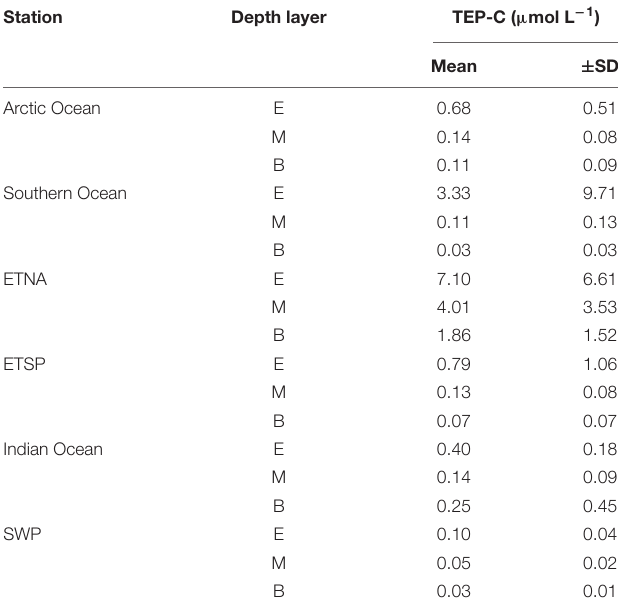
TABLE 2 | Concentrations of carbon contained in TEP (TEP-C) for different stations and depths of the global ocean.